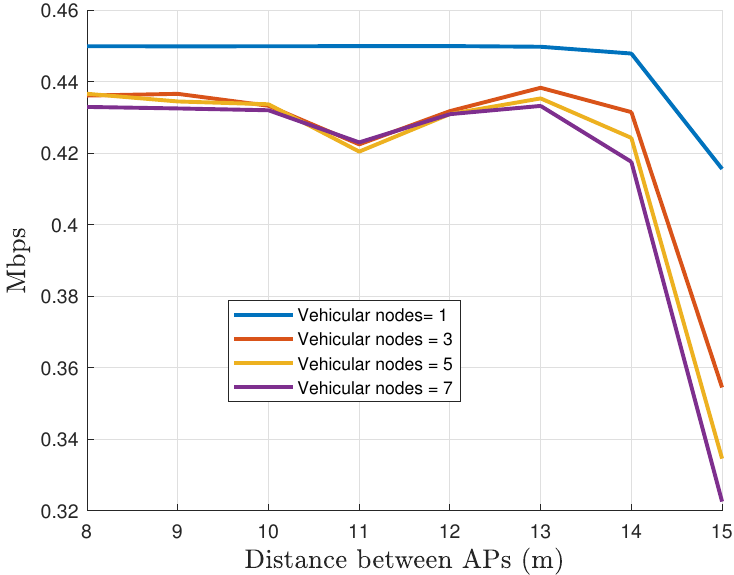
Figure 24. The data rate per vehicular node for different number of vehicular nodes operating in the